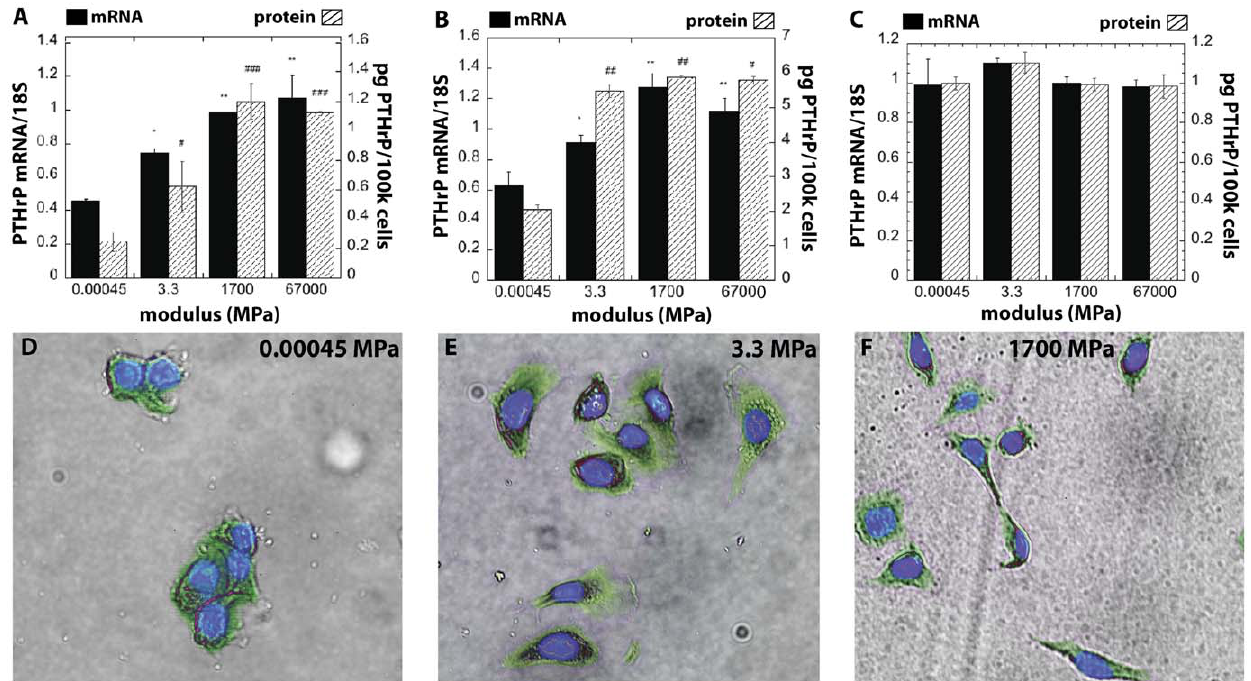
Figure 2. Expression and secretion of PTHrP by osteolytic, metastatic tumor cells increases with increasing substrate modulus. PTHrP mRNA normalized by 18S as measured by qPCR and secreted PTHrP as measured by IRMA for (A) MDA-MB-231 , (B) RWGT2, and (C) MCF-7 cells on substrates of increasing elastic modulus. *, # =p , 0.05; **, ## =p , 0.01; ***, ### =p , 0.005 compared to 0.00045MPa value. Changes in MCF-7 cells were not significant. (D)–(F) Morphology of MDA-MB-231 cells cultured on substrates of varying elastic modulus 4 hours post-attachment. Nuclei were stained using DAPI (blue) and cells were visualized with both visible light and GFP (green). Similar effects of the modulus on cell morphology were observed for RWGT2 cells, while no effects were observed for MCF-7 cells.